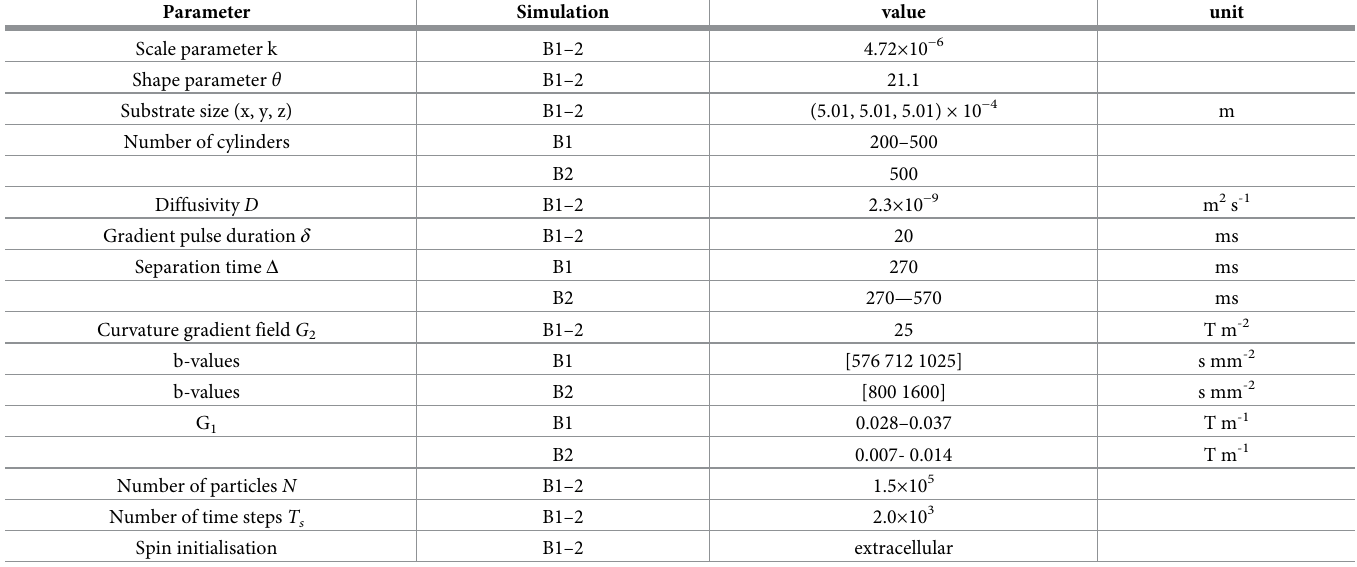
= 4.1 μ m. The parallel cylinders are infinitely long and aligned with the z-axis. The thus obtained scale parameter k and shape parameter θ (see Table 3) were then used to generate a substrate consisting of a fixed number of non-overlapping infinitely long cylinders parallel to the z-axis with random packing geometry. The substrate size was constant. The substrates are periodic along the edges, i.e. overlapping cylinders are simply continued on the opposite site. Table 3. Physical and scan parameter for simulations on the numerical fibre phantom. Parameter Simulation value